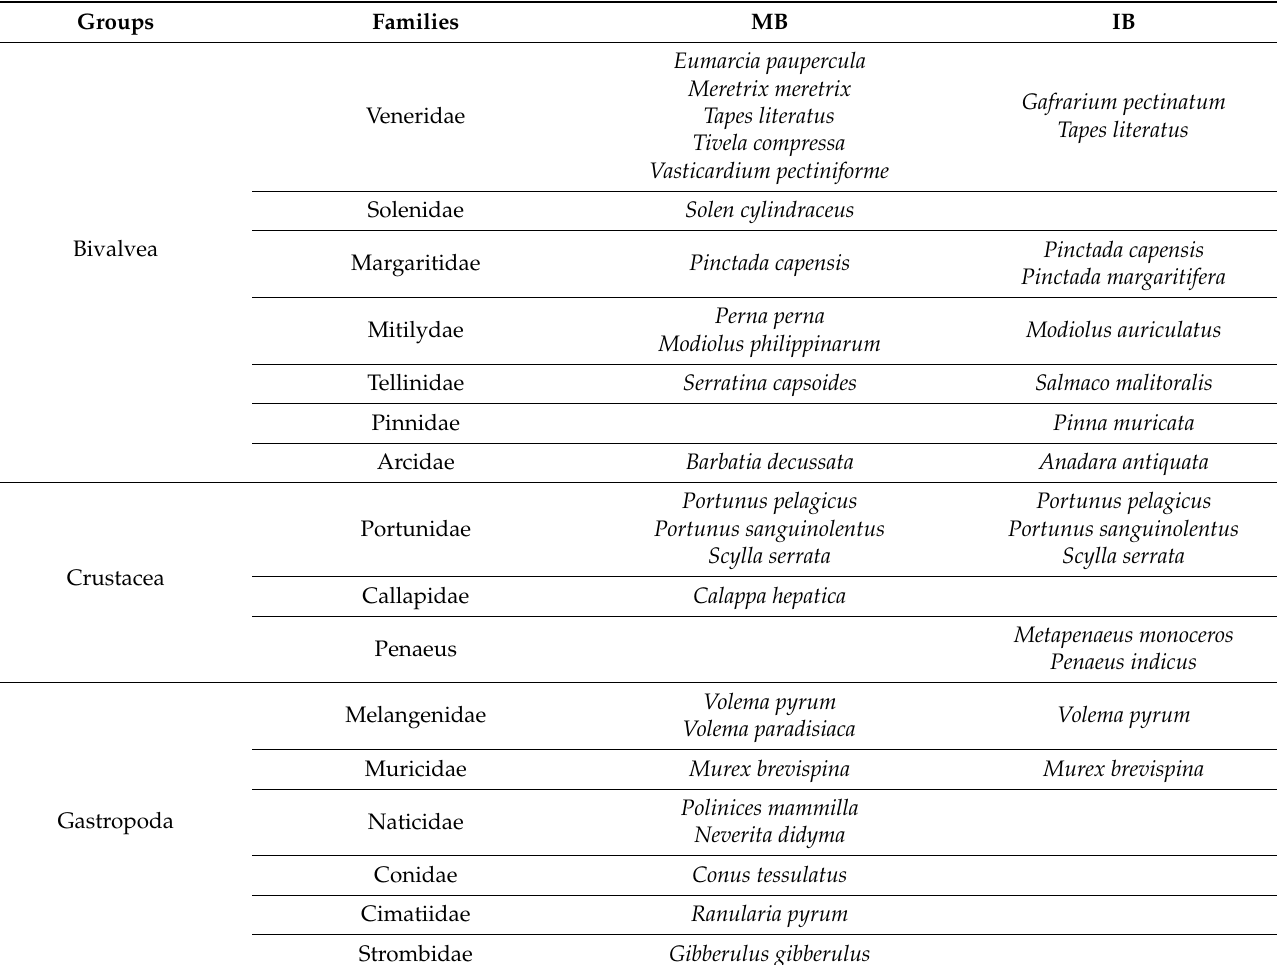
Table 4. List of seagrass edible invertebrates collected in Maputo Bay (MB) and Inhambane Bay